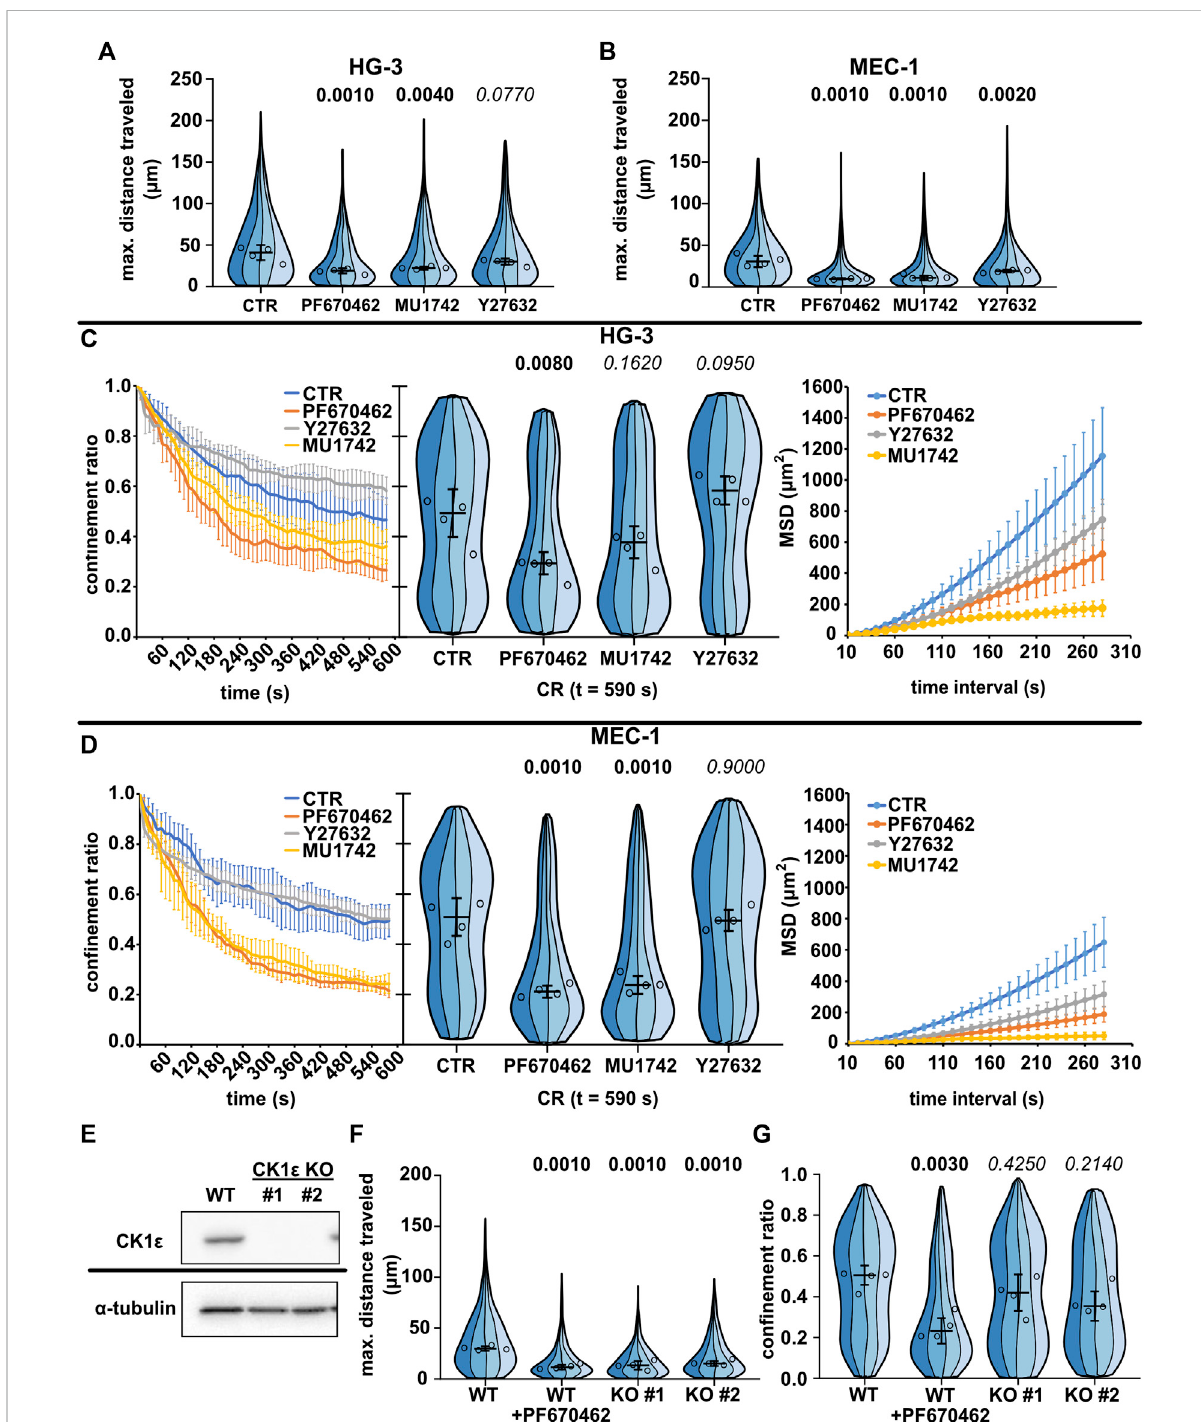
FIGURE 3 Effects of CK1 inhibitors PF670462 and MU1742 and a ROCK inhibitor Y27632 on the basal migratory properties of the CLL cell lines. (A) Maximum distance traveled by HG-3 cells treated with 10 μ M of one of the indicated inhibitors or an equal volume of DMSO (CTR). Statistics: one- way ANOVA, n = 4, p < 0.001, and the post hoc Tukey test ( p values of comparison to CTR condition). (B) Maximum distance traveled by MEC-1 cells in the same experimental setup. Statistics: one-way ANOVA, n = 4, p < 0.001, and the post hoc Tukey test). (C) Analysis of HG-3 migratory persistence under the effect of CK1 and ROCK inhibitors. Left: Decay of CR over the period of tracking. Center: CR values at the last frame of the tracking period (t = 590 s). Statistics: one-way ANOVA, n = 4, p < 0.001, and the post hoc Tukey test. Right: MSD analysis. (D) Analysis of MEC-1